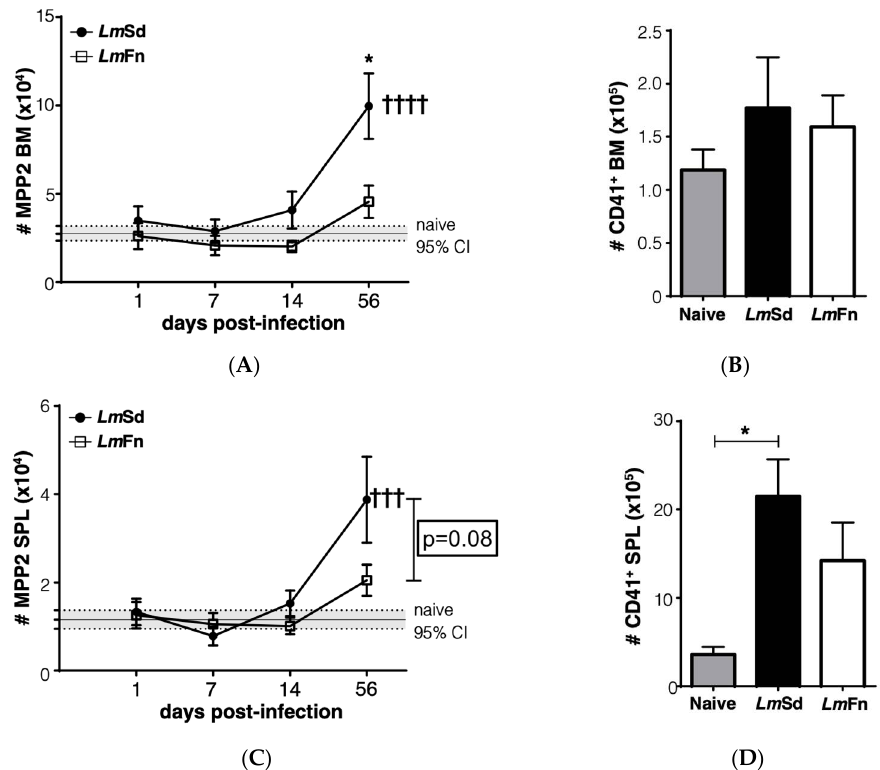
Figure 4. Accumulation of platelet-biased multipotent progenitors in bone marrow and spleen in Lm Sd-infected mice: ( A ) The number of cells within the CD48 + CD150 + CD135 − MPP2 subset of hematopoietic progenitor cells in the bone marrow at different times post-infection. ( B ) Analysis of the number of CD45 − CD41 + platelets in the bone marrow on day 56 post-infection. ( C ) Number of MPP2 cells in the spleen at different times post-infection. ( D ) Analysis of the number of CD45 − CD41 + platelets in the spleen on day 56 post-infection. Graphs represent compiled results (mean ± SEM) from at least 4 independent experiments for each time point, with n = 13, n = 11, n = 11, and n = 15 mice per group ( Lm Fn vs. Lm Sd) at 1-, 7-, 14-, and 56-days post-infection, respectively, for MPP2 analysis; and from 2 independent experiments with n = 7 mice per group for platelet analysis. The grey horizontal line and shaded area in panels ( A ) and ( C ) represent mean ± 95% confidence interval for naïve control mice. * p < 0.05 comparing infection with Lm Fn vs. Lm Sd at a given time point and †††, †††† p < 0.05 comparing infected groups ( Lm Fn or Lm Sd) to naïve control mice. See also Supplementary Figures S2 and S4 for flow cytometry gating strategies and representative results.